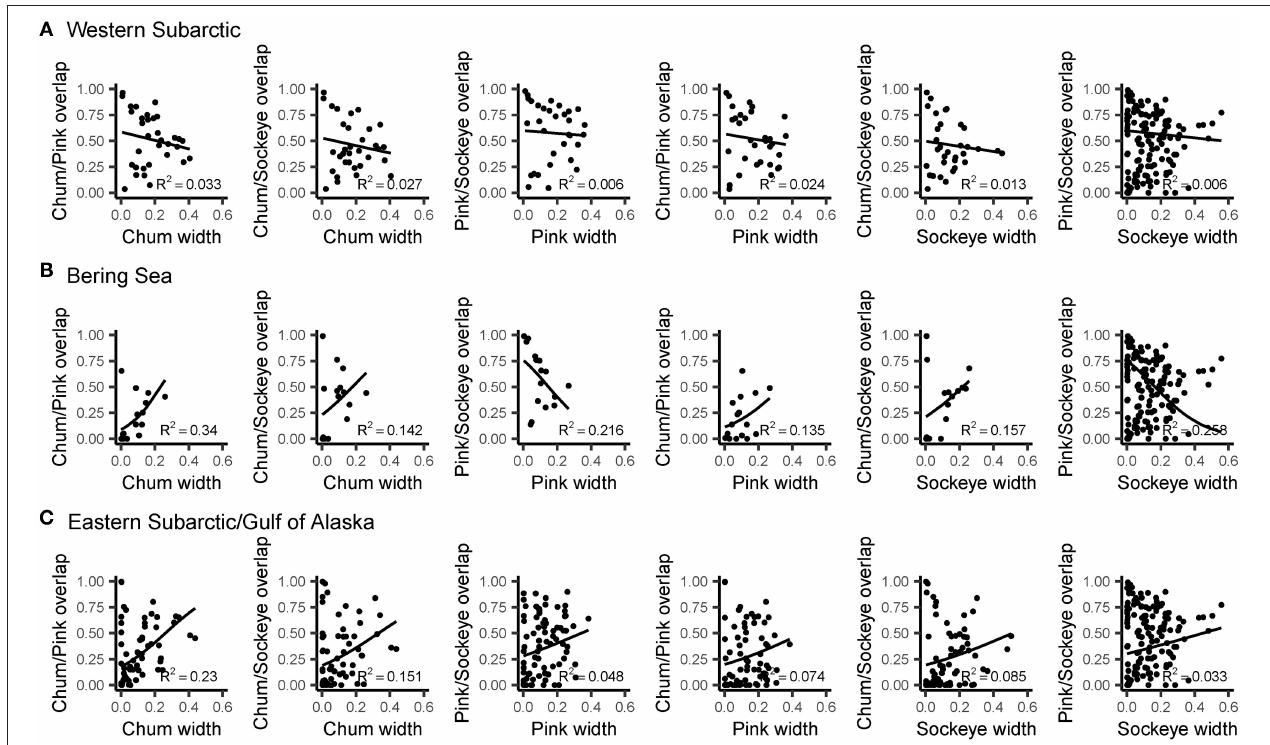
FIGURE 7 | The relationships between trophic niche width for salmon species and trophic niche overlap between species pairs fitted using beta regression with a logit link function. Results are displayed by region: (A) Western Subarctic, (B) Bering Sea, (C) Eastern Subarctic/Gulf of Alaska. Prior to regression, data were transformed using [ y · ( n – 1) + 0.5]/ n , where n is sample size, to remove values of 0 and 1. The R 2 value represents the pseudo- R 2 value, which is calculated by squaring the correlation of the linear predictor and link-transformed